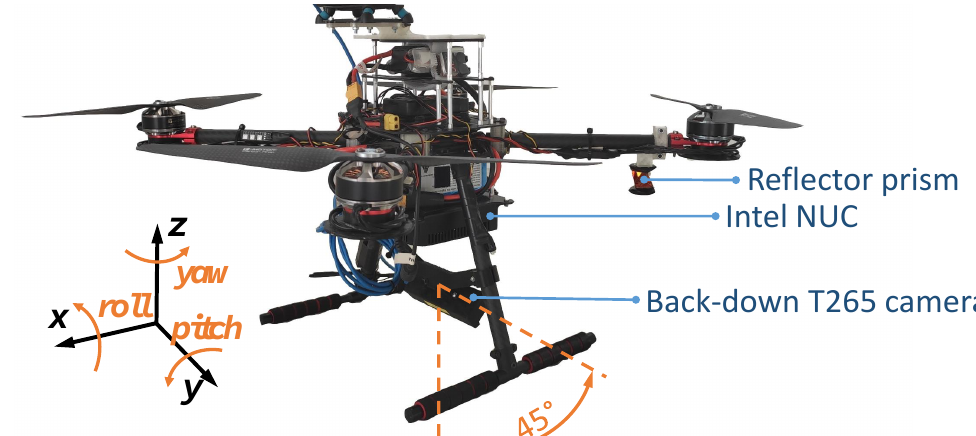
Figure 4. Aerial platform with its different components. One camera is pointing forward and the other one downward, with a 45 ◦ angle to the back.